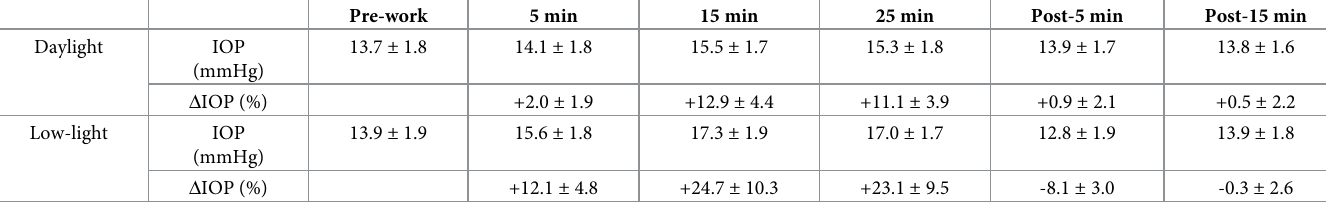
Table 2. IOP changes of study